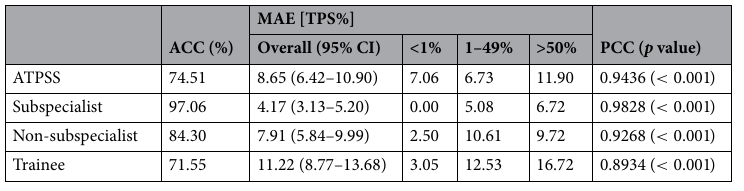
Table 2. The performance of ATPSS and pathologists for PD-L1 tumor proportion score assessment.